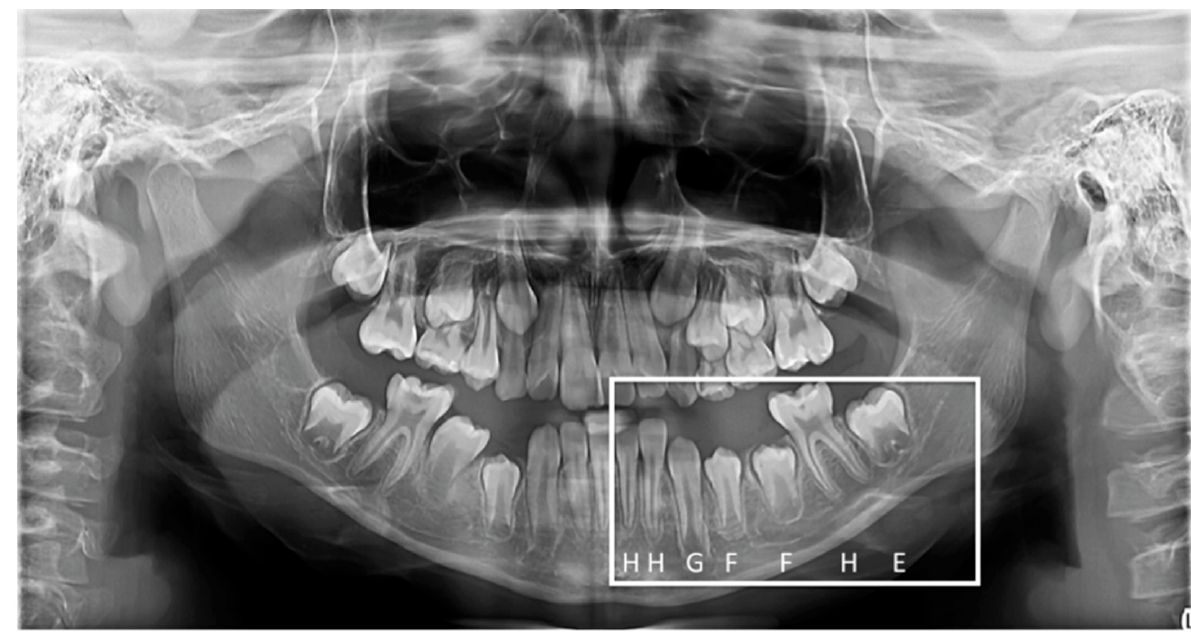
Figure 1. Dental age assessment using the Demirjian method.